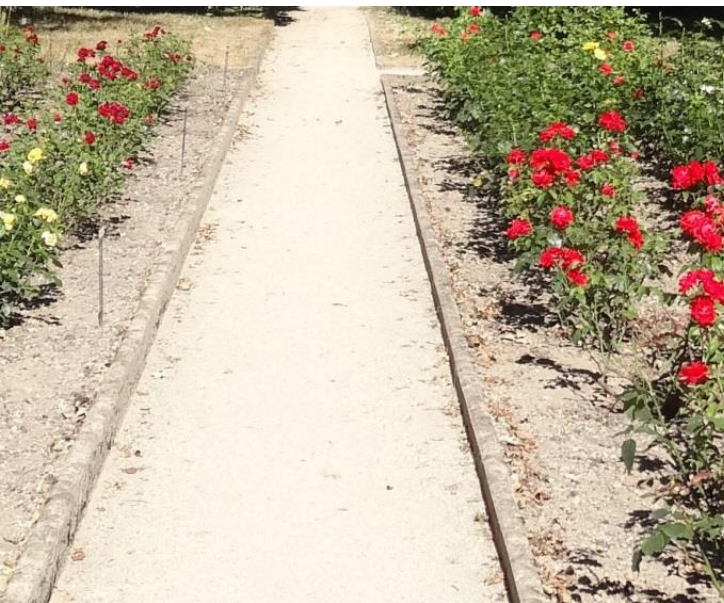
Figure 3. An element of garden architecture (B. Vojvodikova).